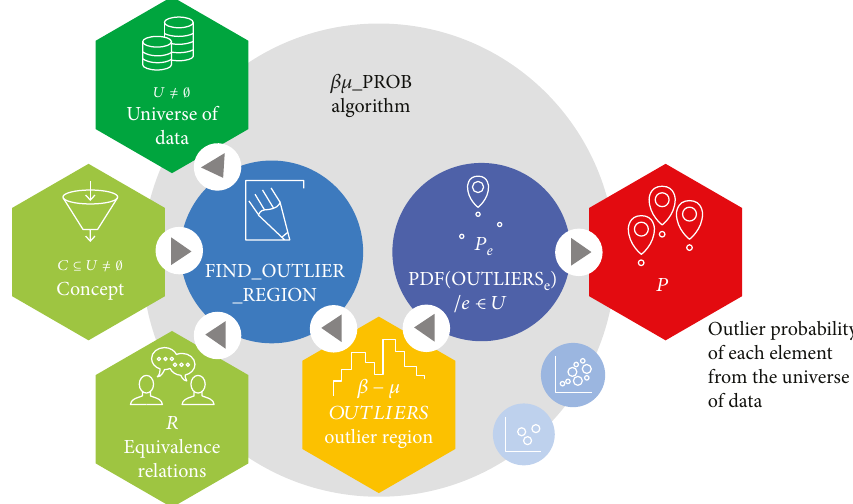
Figure 2: General outline of the proposed